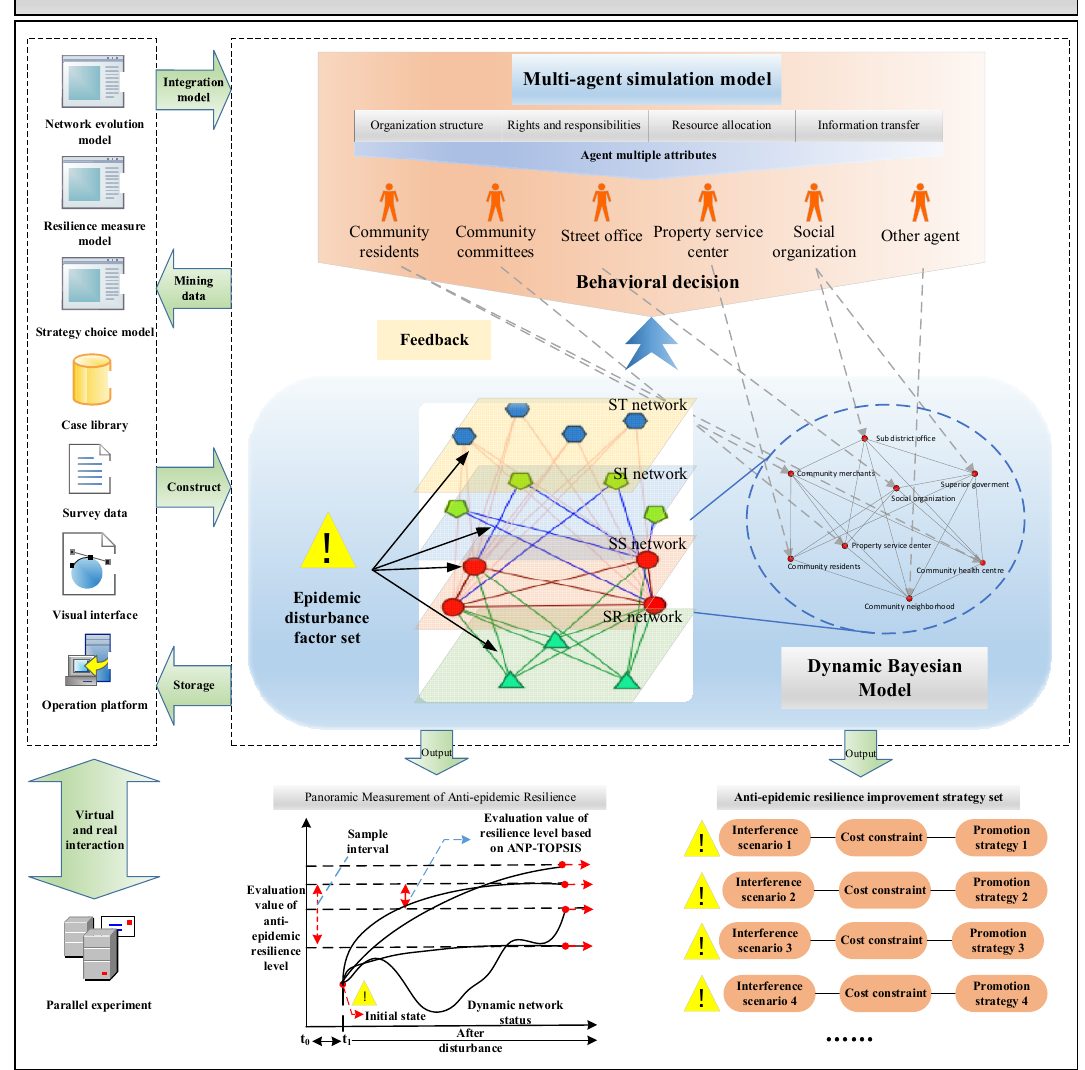
Figure 5. Intelligent simulation platform for urban community anti-epidemic resilience improve- ment